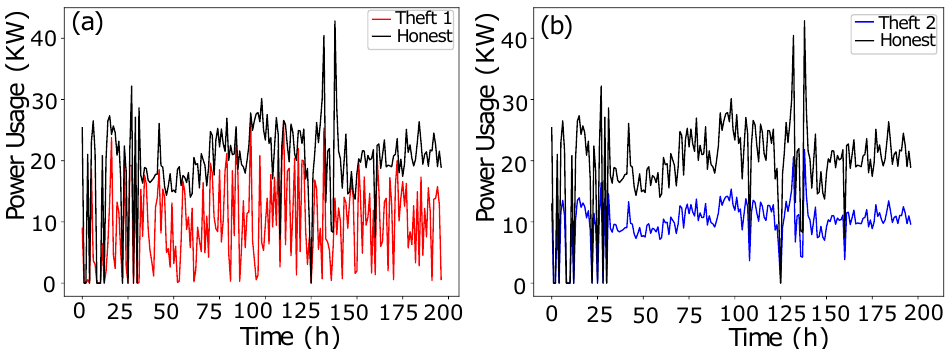
Figure 2. ( a ) Theft Case 1. ( b ) Theft Case